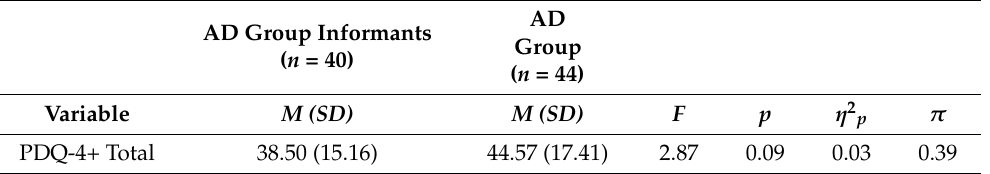
Table 1. Result of the Variance Analysis (ANOVA) of the AD Group Informants and the AD Group on the Global Personality Disorder Index (PDQ-4+ Total).